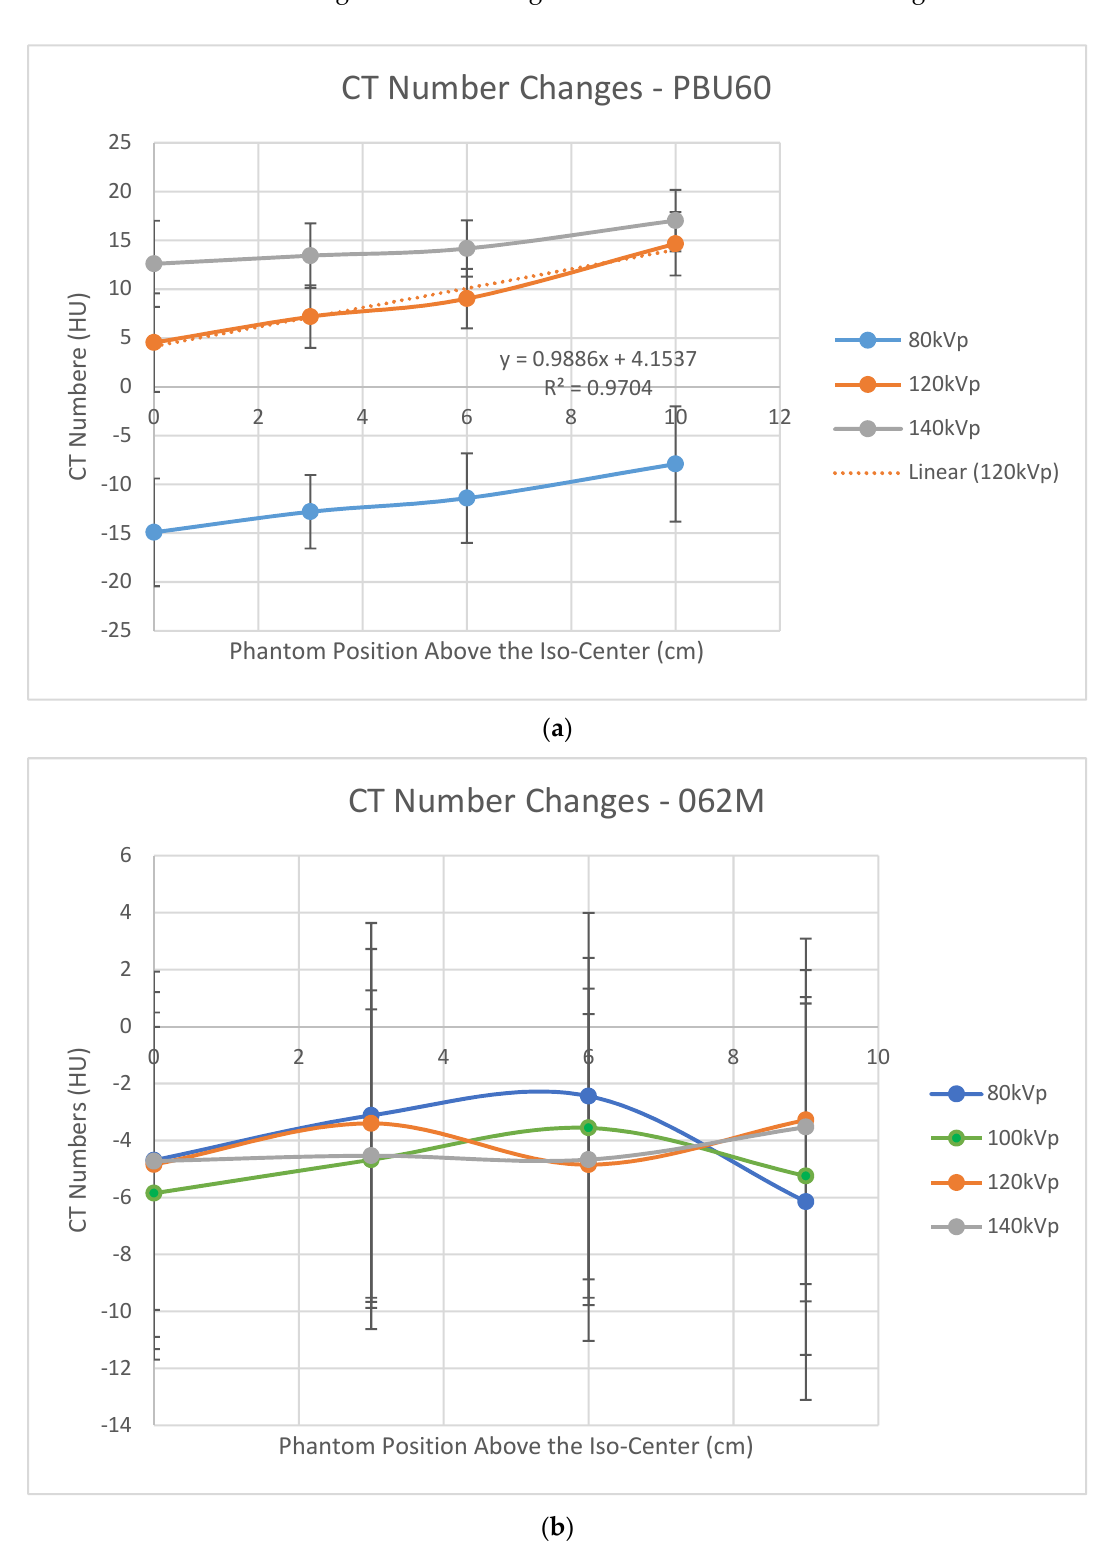
Figure 3. CT number variations as phantoms are lifted above the iso-center; ( a ) the PBU60 phantom using the HD750 scanner; ( b ) the 062M phantom using the APEX scanner.